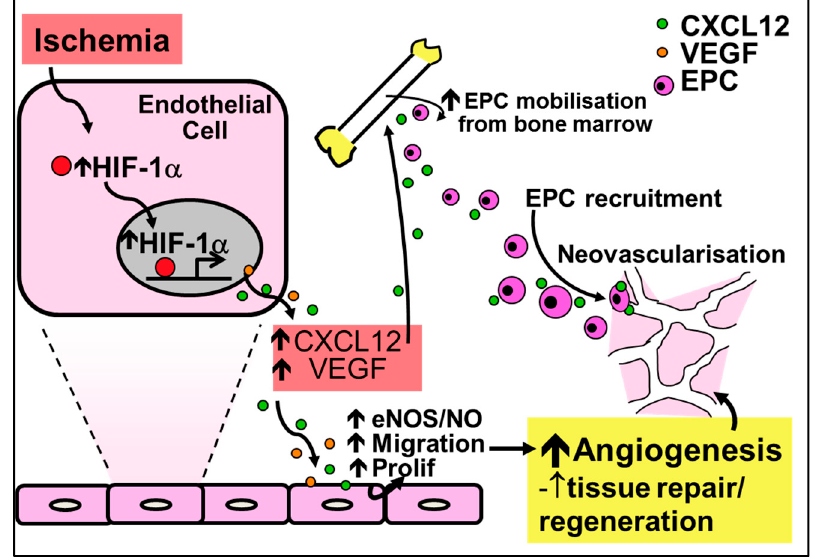
Figure 3. Regulation of ischemia-mediated physiological angiogenesis by the CXC-chemokine CXCL12. Increased HIF-1 α in response to ischemia causes the release of CXCL12 and VEGF, leading to increased nitric oxide production and augmented endothelial migration and proliferation to promote angiogenesis. Furthermore, CXCL12 upregulates the recruitment and mobilization of EPCs to sites of ischemia. Increased nitric oxide from the induction of CXCL12 further mobilizes EPCs and increases the production of VEGF for neovessel formation.